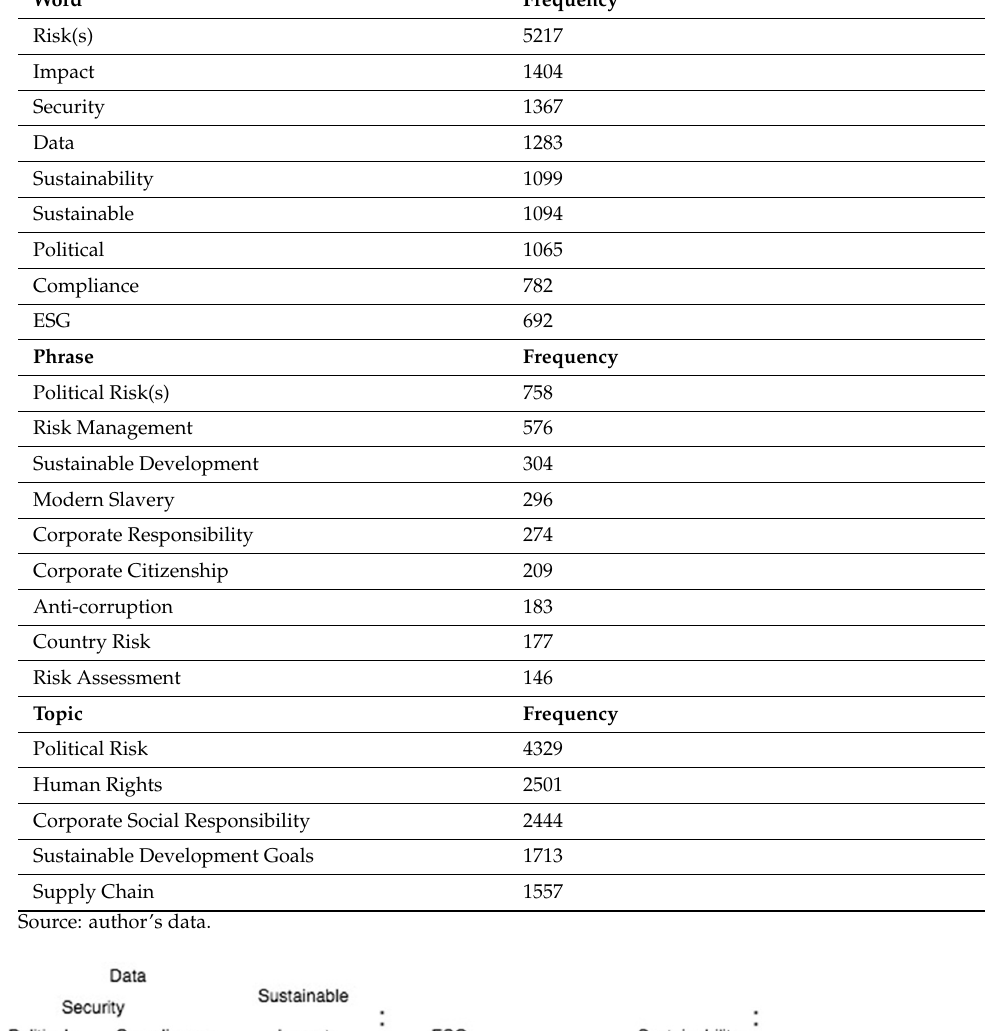
Table 3. Frequencies of words, phrases and topics for the re-embedding process.